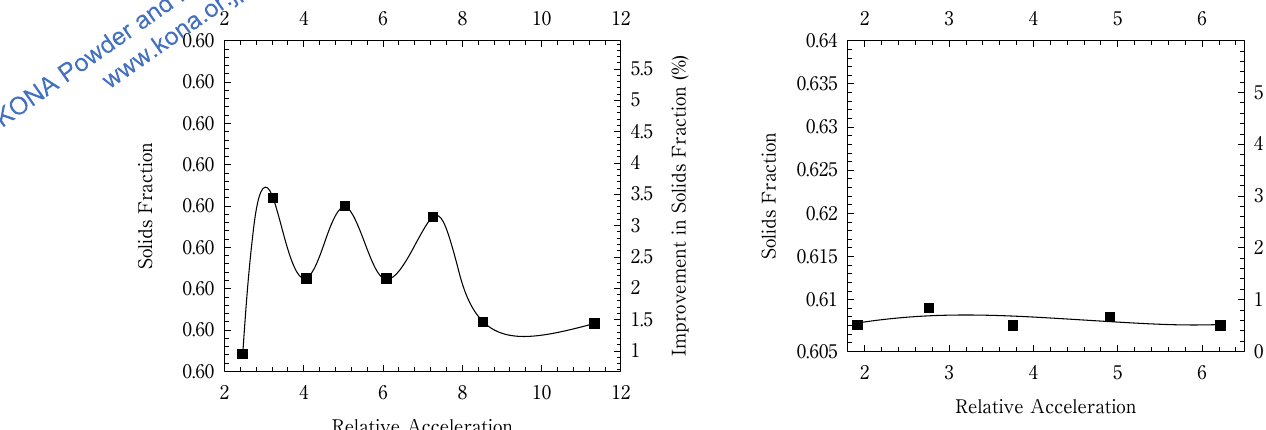
Fig. 4 Solids fraction versus relative acceleration at a/d = 0.16. The solid line is a best fit curve to show the trend.